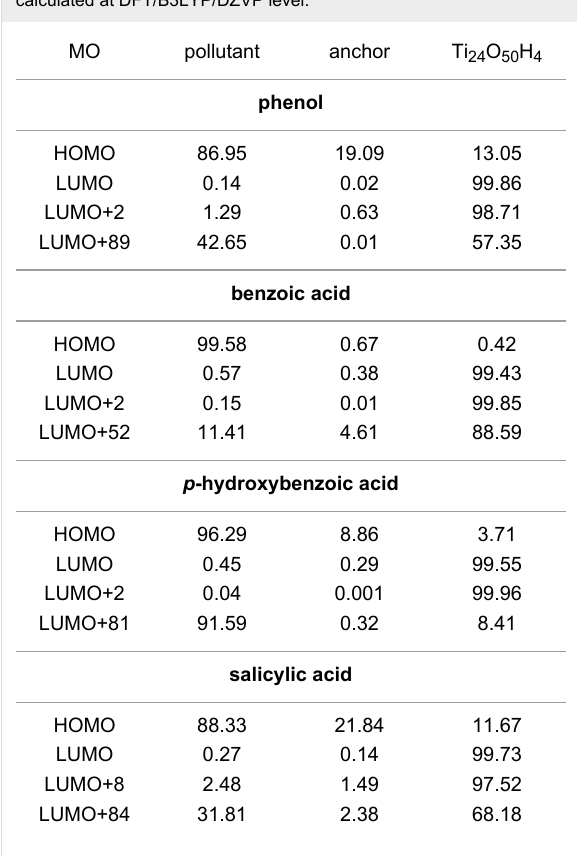
Table 5: Contributions of pollutant, anchor group, and substrate, in %, to the electron density of MOs involved in lowest electronic transitions, calculated at DFT/B3LYP/DZVP